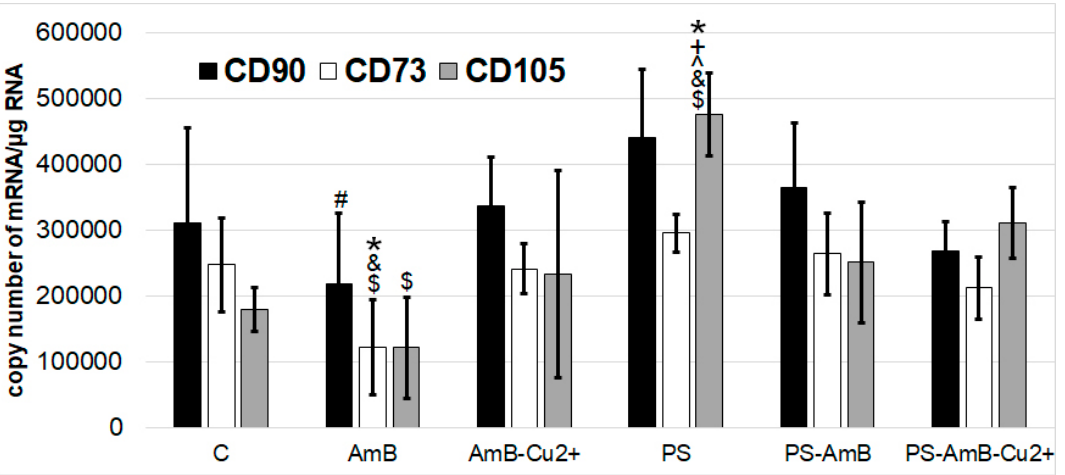
Figure 3. The mRNA levels of MSC markers CD73 , CD90 and CD105 in the ADSC after exposure to the tested antibiotic combinations (RT-qPCR analysis). The bars represent the means ± standard deviation (SD) of the copy numbers per 1 µg of total RNA; ANOVA with the Tukey post hoc test, * p < 0.05 vs. control, # p < 0.05 vs. PS, ^ p < 0.05 vs. AmB-Cu 2+ , + p < 0.05 vs. AmB, & p < 0.05 vs. PS-AmB, $ p < 0.05 vs. PS-AmB-Cu 2+ .